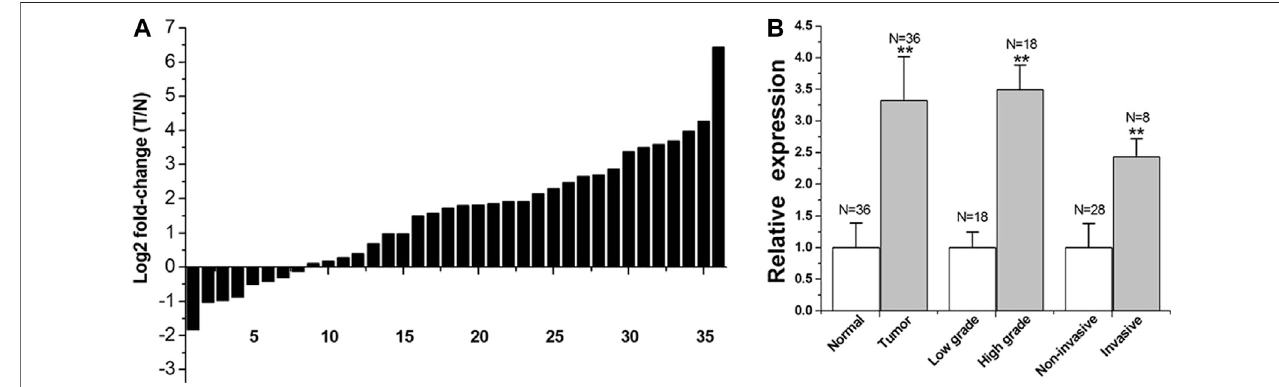
FIGURE 1 | LINC00341 was overexpressed in bladder cancer.qRT-PCR was employed to explore LINC00341 relative expression. In each control group, the relativeexpressionvalueofLINC00341wassettoabasicvalueof1.N,thenumberofsamplesineachgroup. (A) .TstandsfortumorandNstandsfornormal.Theheight of each column in the chart indicates the fold change (tumor/non-tumor) expressed by LINC00341 in 36 patients after log 2 conversion. (B) . Comparing the expression levelofLINC00341 betweentumor andhealthytissues(** p < 0.01).Differencesintheexpression ofLINC00341 betweenhigh-gradecancerandlow-gradecancer was compared (** p < 0.01). The expression level of LINC00341 in invasive cancer and non-invasive cancer was compared (** p < 0.01).